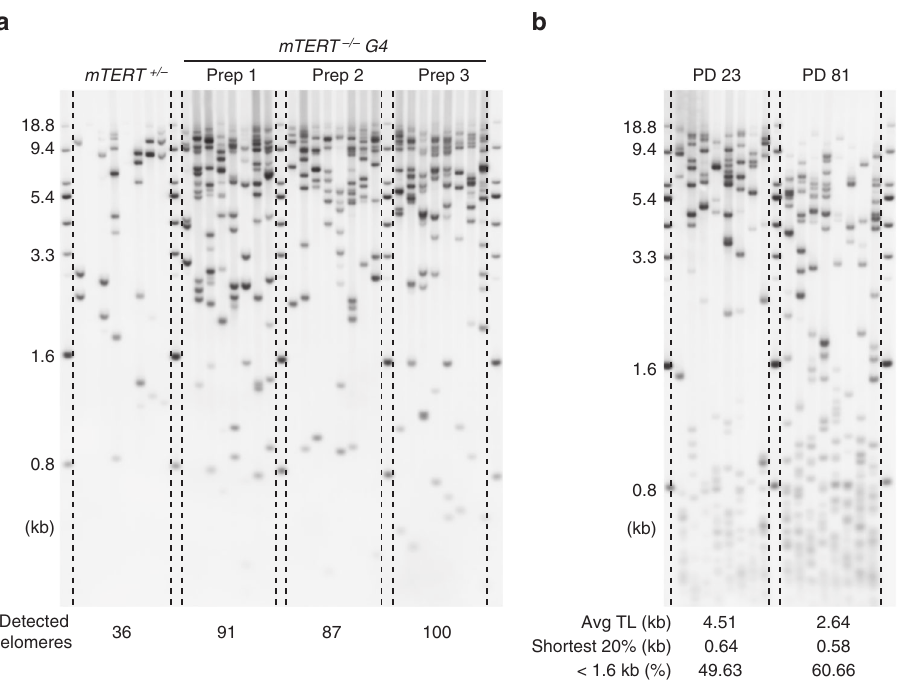
Fig. 7 TeSLA for telomere detections in mTERT knockout mice and lung fi broblasts from a bowhead whale. a DNA extracted from mTERT + / − and mTERT − / − (4th generation, G4) mouse liver tissues were used to perform TeSLA (30 pg for each TeSLA reaction). Detected telomeres of three individual genomic DNA preps from the same mTERT − / − G4 mouse (91, 87, and 100 bands) are considerably more than telomeres that were detected from mTERT + / − liver tissue (36 bands). b TeSLA results of high-quality DNA extracted from early (PD 23) and late (PD 81) passages of cultured bowhead whale lung fi broblasts. Both early and late passage cells contain a subset of the shortest telomeres that have not been identi fi ed by TRF